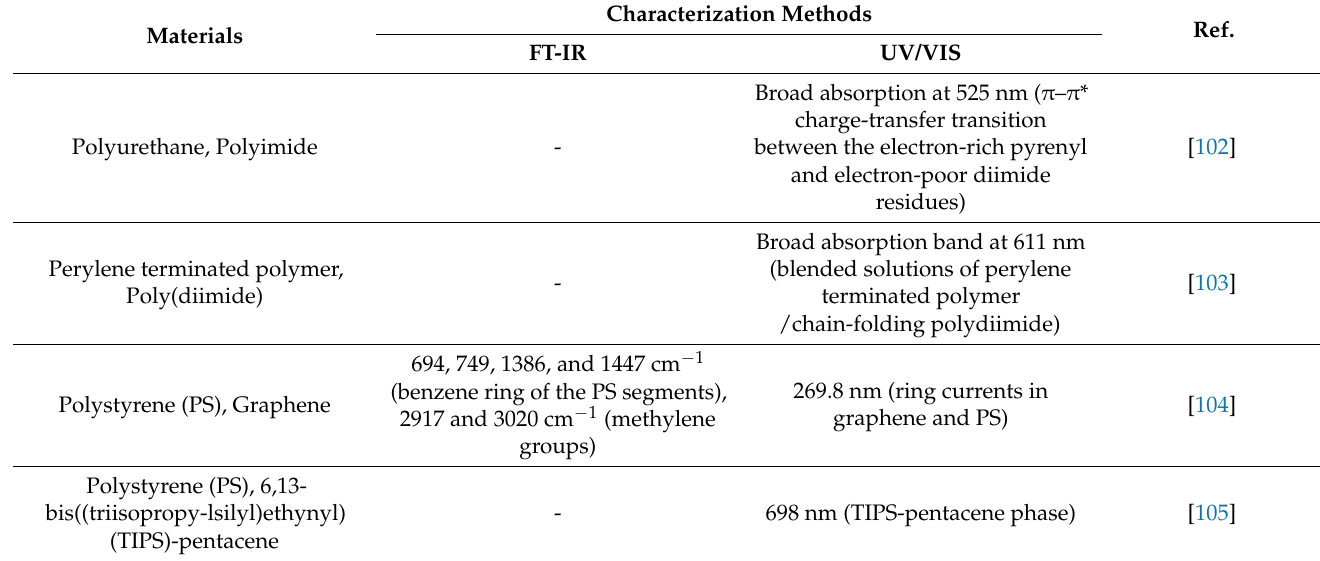
Table 4. Overview of characterization methods for π – π